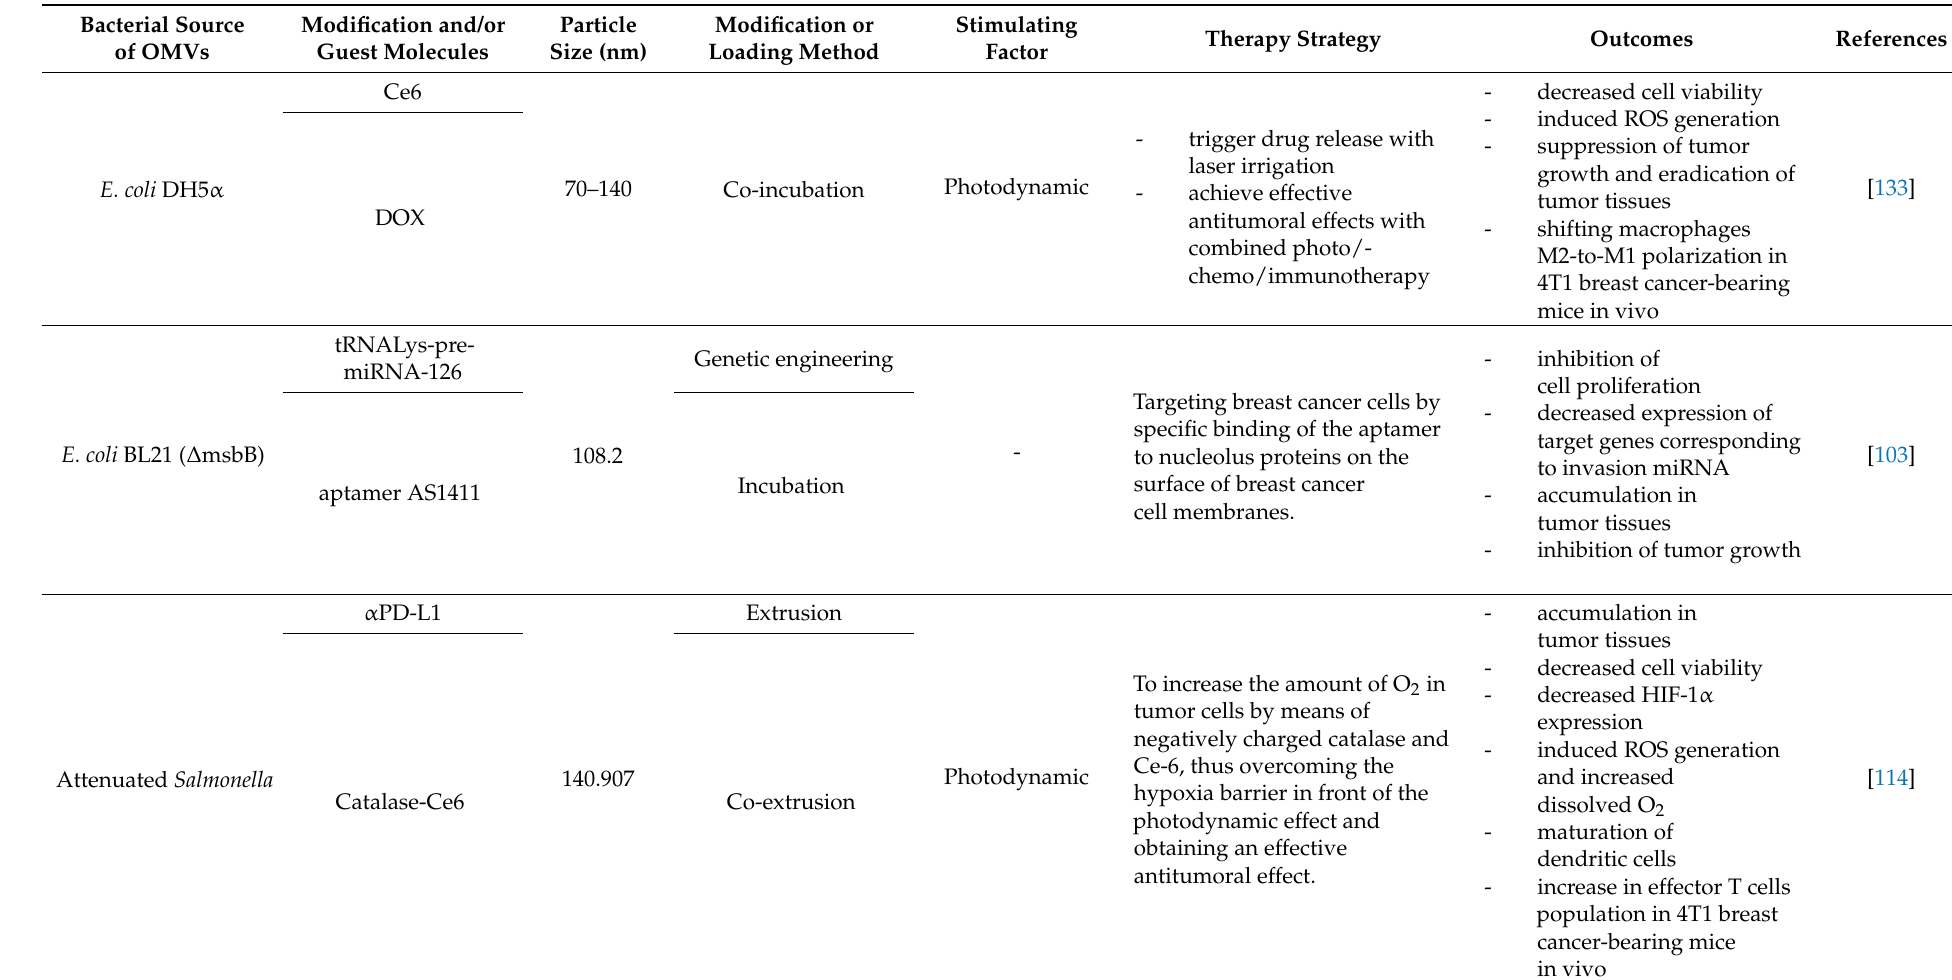
Table 3. Application of OMVs as smart delivery systems in cancer